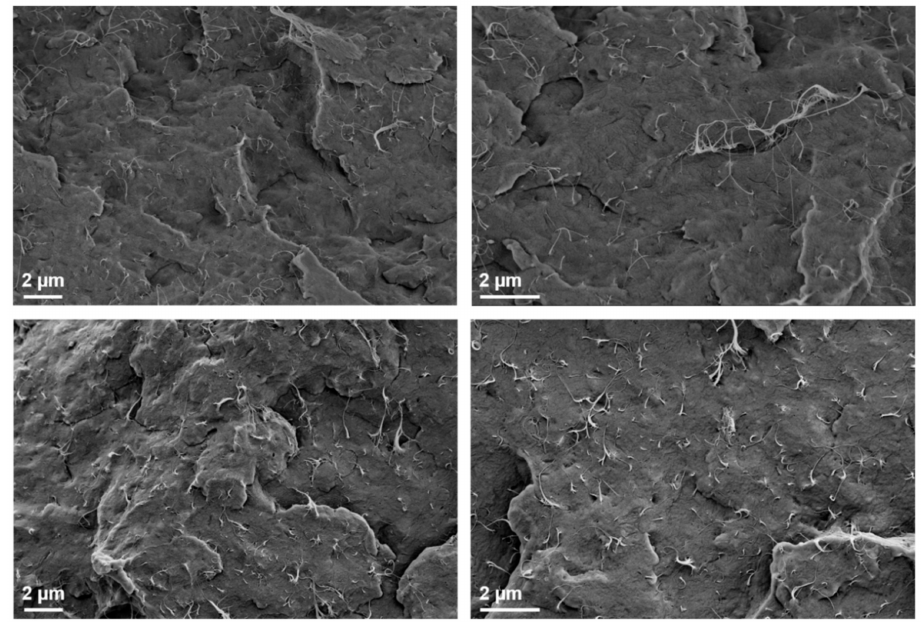
Figure 7. SEM micrograph cryofractured surfaces of PP / 1 wt% B-SWCNT ( top ) and PP / 1 wt% SWCNT ( bottom )